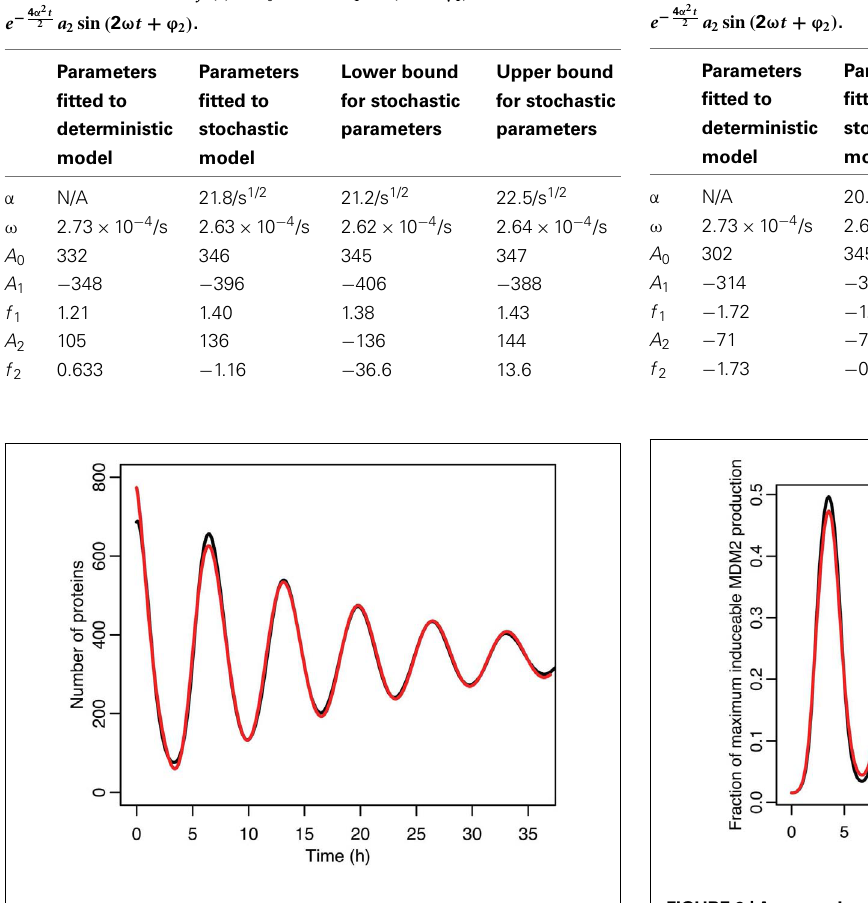
FIGURE 8 | Comparison of nuclear MDM2 levels in the stochastic model in black to a curve fitted to it from the function f ( t ) = a 0 + e − α 2 t 2 a 1 sin ( ω t + ϕ 1 ) + e − 4 α 2 t 2 a 2 sin ( 2 ω t + ϕ 2 ) in red.